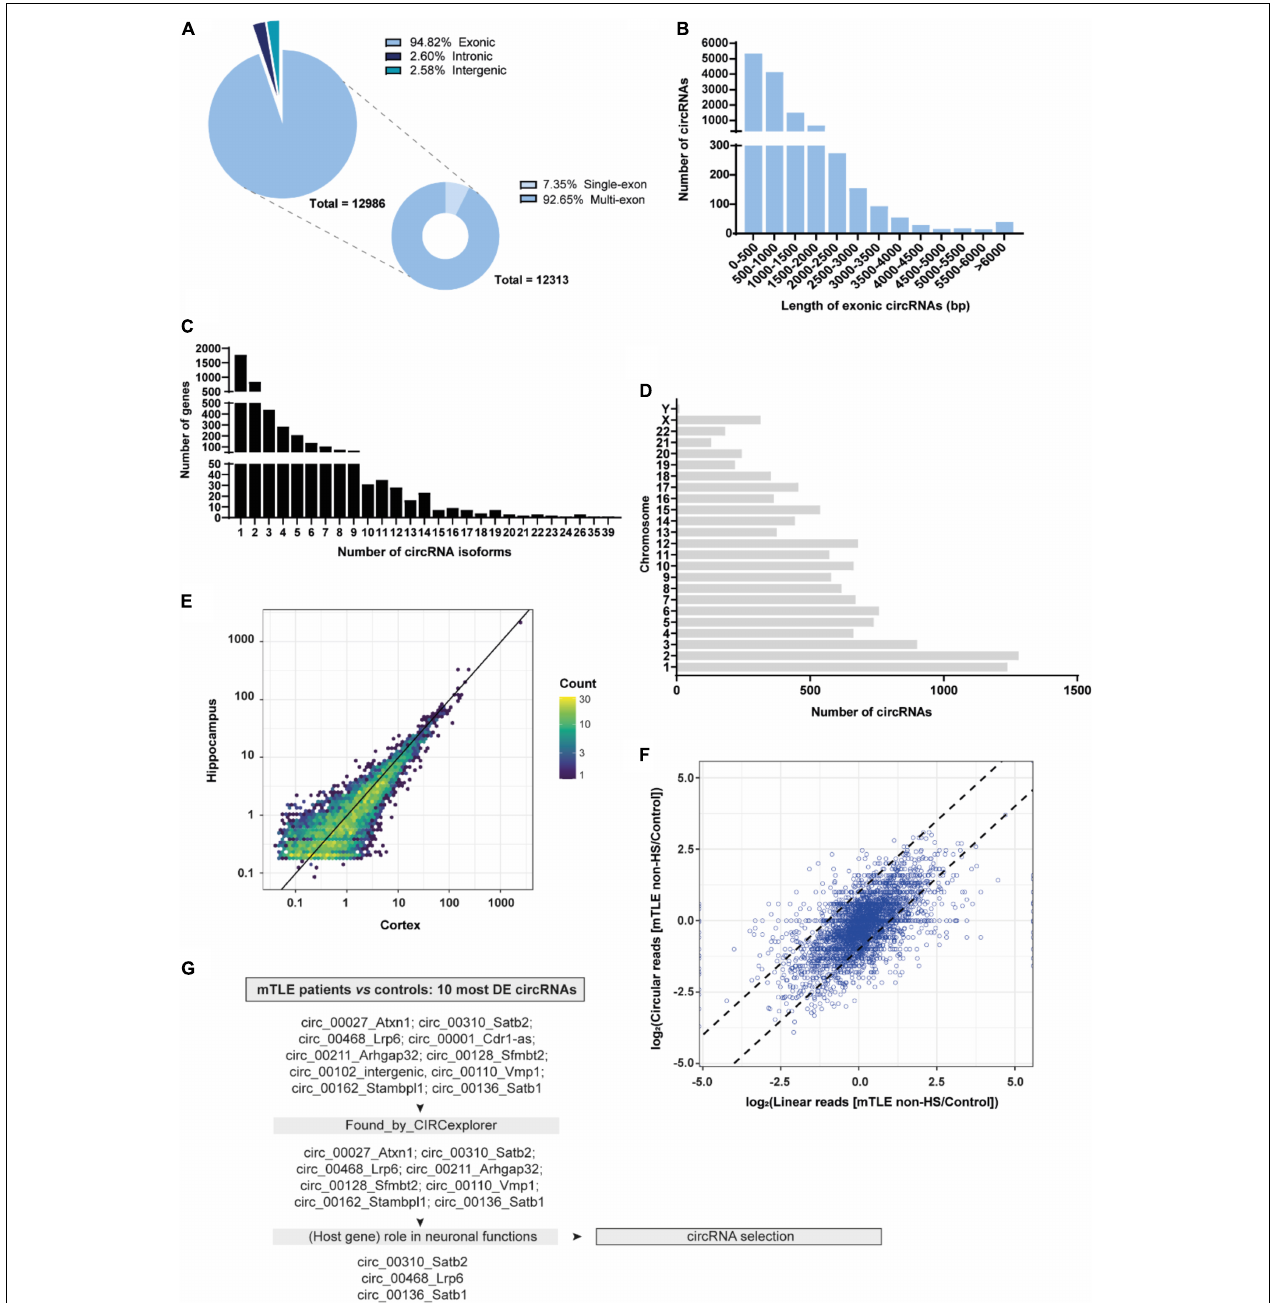
FIGURE 1 | CircRNA profiling of autopsy controls and mTLE patients. (A) RNA composition of all detected circRNAs (exonic, intronic, and intergenic). (B) Exonic length distribution of detected circRNAs. N = 12313 (bp, base pairs). (C) Distribution of circRNA isoforms across detected circRNAs from both cortex and hippocampus. N = 12986, of which n = 11914 were detected in the cortex and n = 6947 in the hippocampus. Number of circRNA isoforms were calculated per host gene. (D) Distribution of detected circRNAs across human chromosomes. (E) Scatter plot representing the mean normalized expression (nucleus and cytoplasm) of circRNAs in the cortex ( x -axis) and hippocampus ( y -axis). Color scale indicates the number of overlapping circRNAs. Expression values were log 10 transformed to allow visualization of all circRNAs. (F) Expression correlation of circular and linear RNA splicing in hippocampal samples. The plot shows the log2 linear fold change on the x -axis and log2 circRNA fold change on the y -axis between mTLE non-HS and control samples, ± 1 log2 fold change is indicated by the dashed lines. CircRNAs with expression correlated to the host gene linear transcript are in the central diagonal and non-correlated circRNAs are depicted outside of the diagonal. (G) Schematic workflow representation of the pipeline used to select circRNAs of interest from the 10 most DE circRNAs found after DESeq2 analysis and Benjamini-Hochberg testing correction.